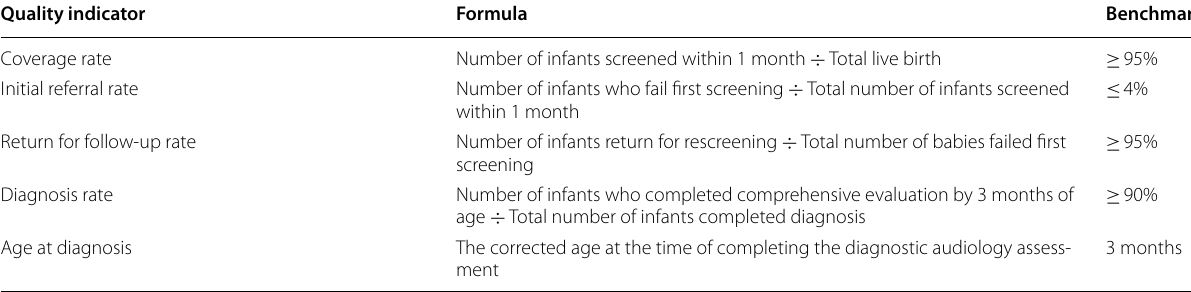
Table 1 Quality indicators, formulae, and recommended benchmarks used in the study Quality